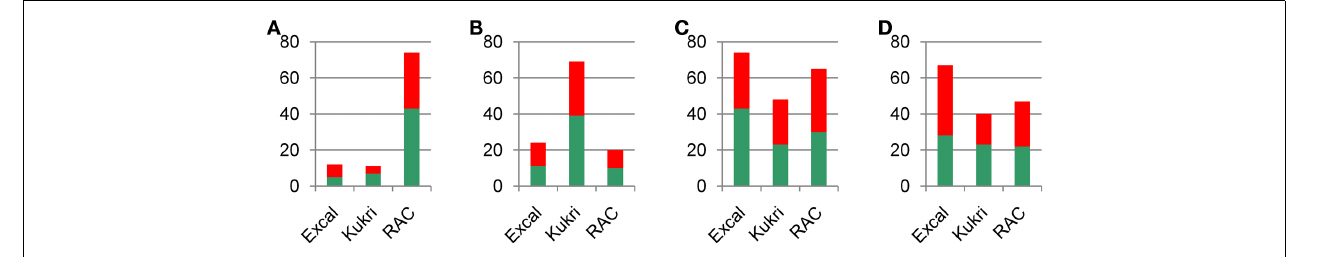
FIGURE 5 | Summary of iTRAQ identified protein changes fromTable S2 in Supplementary Material. The number of protein changes at (A) WS, (B)